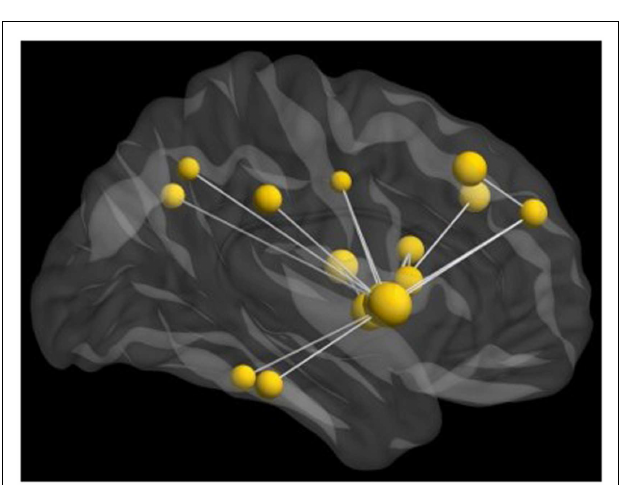
FIGURE 4 | Network of reduced beta-band connectivity seen in adolescents compared to matched controls during the implicit processing of angry faces. The hub of this network was in the right insula, with connections notably to the fusiform gyrus and frontal lobes. For this analysis, data from seed regions were reconstructed using beamformer analysis. Data were then filtered into physiologically relevant frequency ranges, time series of instantaneous phase values were obtained using the Hilbert transform, and inter-regional phase locking was calculated using the phase lag index [PLI; see (Stam et al.,